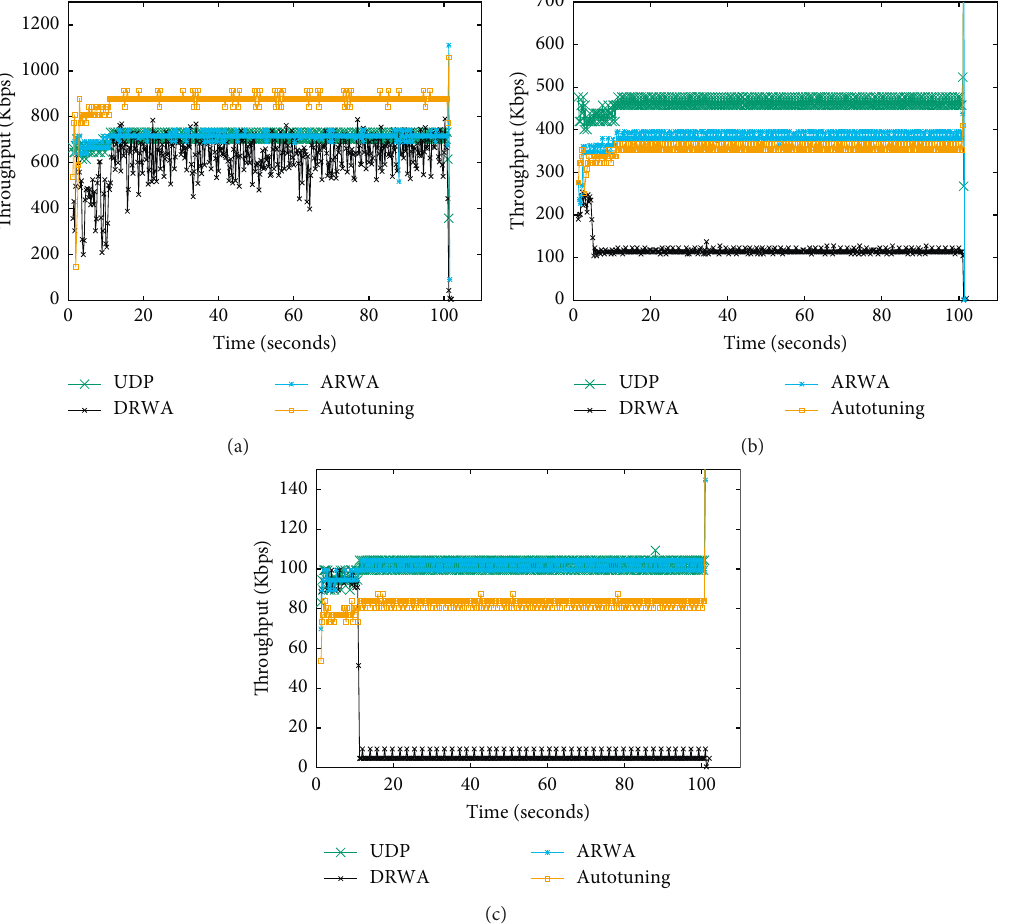
Figure 8: Throughput of different flow methods for various signal strength locations in LTE network. (a) High signal strength location. (b) Medium signal strength location. (c) Low signal strength